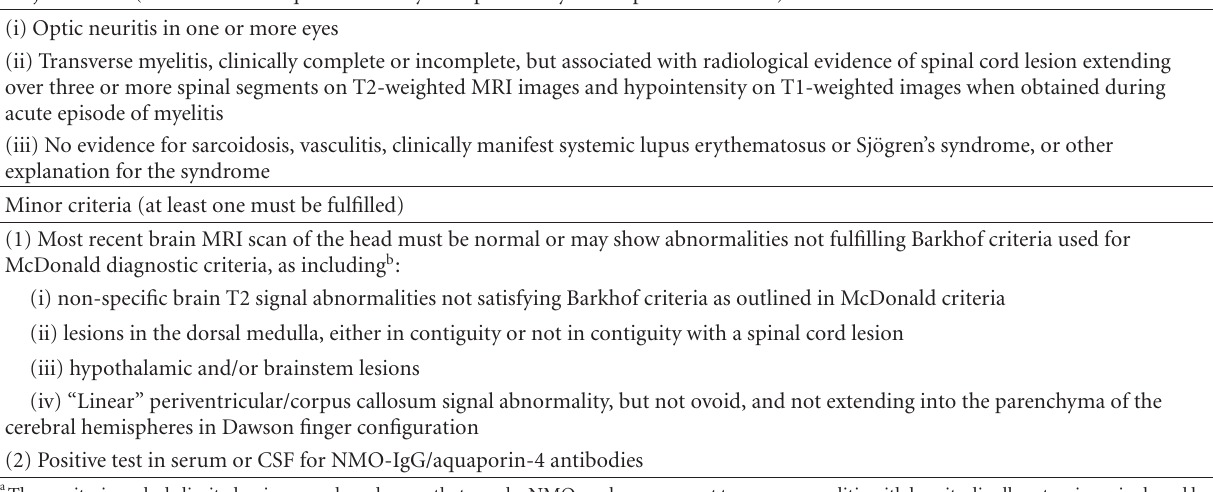
Table 3: Diagnostic criteria of NMO a